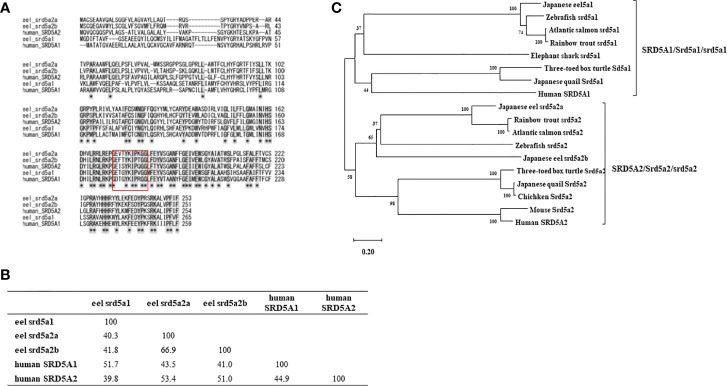
Alignment (A) and identities of amino acid sequence (B), phylogenic analyses (C) for eel srd5a and human SRD5A. (A) Alignment of the deduced SRD5A/srd5a amino acid sequences of eel and human. Conserved NADPH-binding domain (GXXGXXXXXGG) is shown by a box. (B) Comparisons of deduced amino acid identities between eel srd5a1, eel srd5a2a, eel srd5a2b, human SRD5A1 and human SRD5A2. (C) The phylogenetic tree of SRD5A/Srd5a/srd5a proteins. Bootstrap values (100 resamplings) are indicated by numbers.